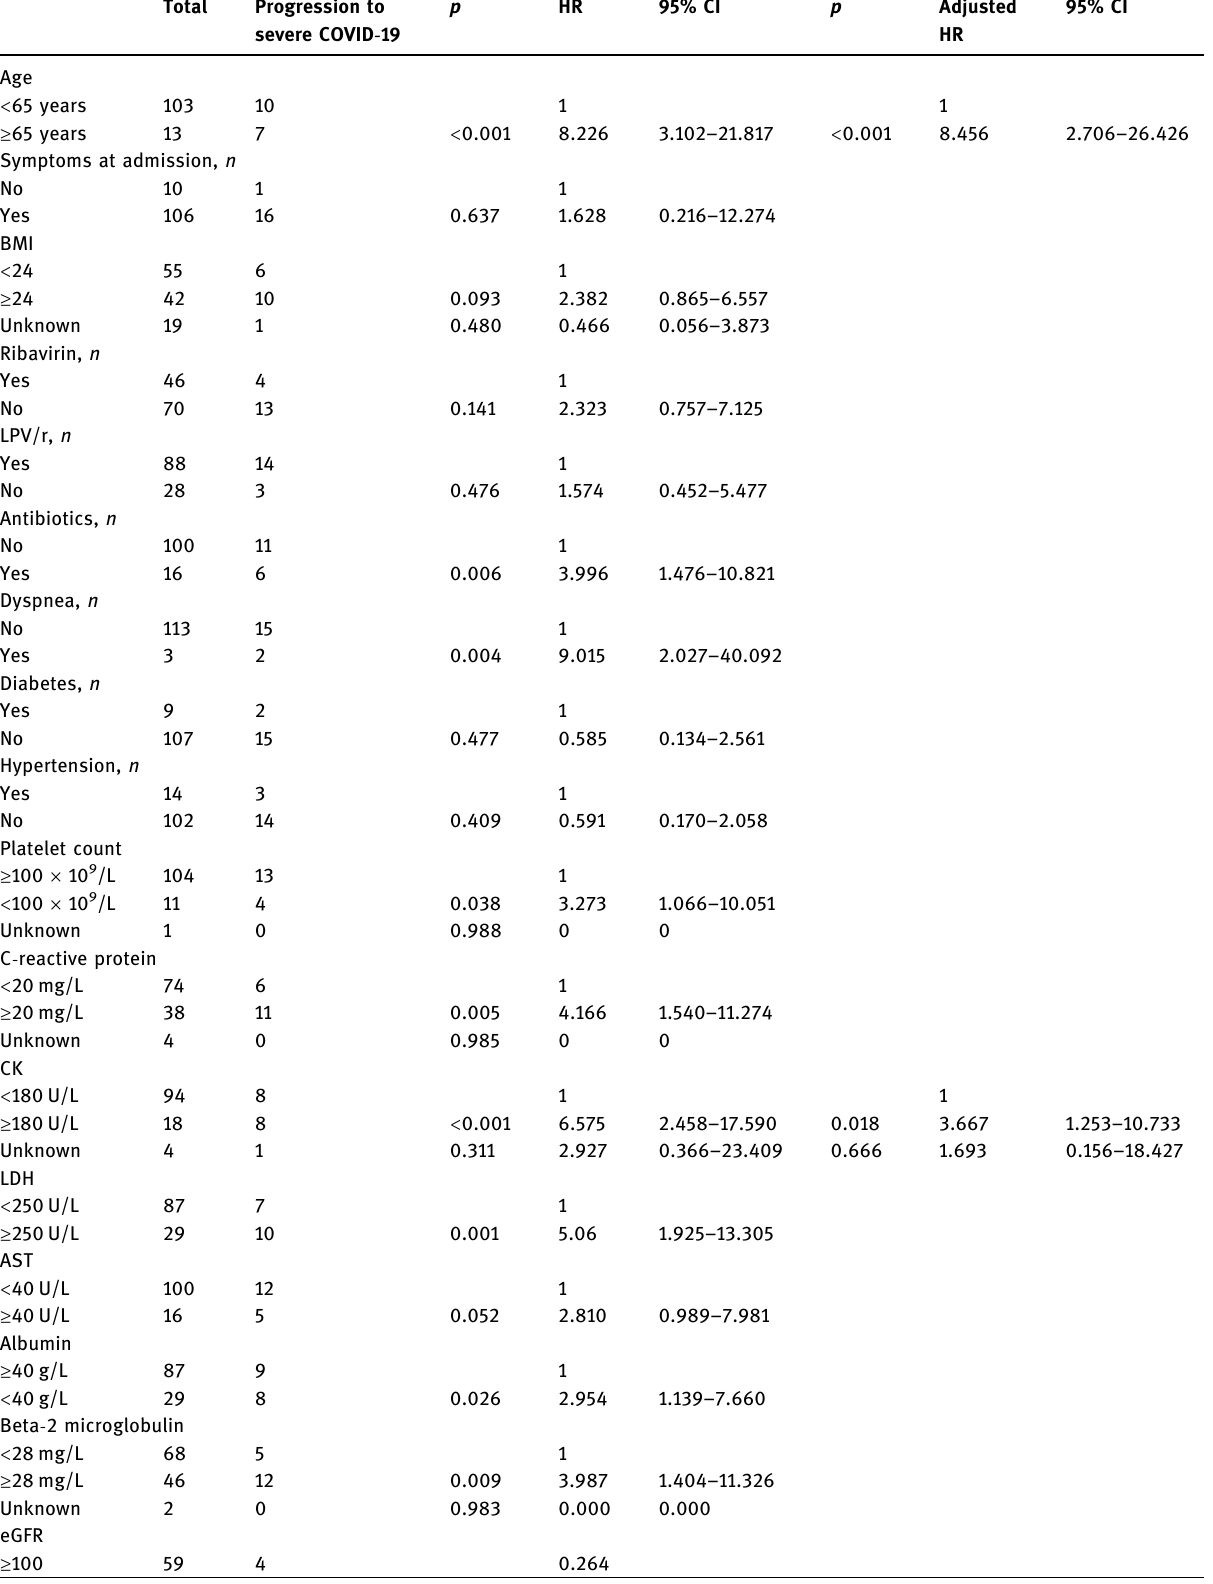
Table 5: Independent risk factors for progression to severe COVID -